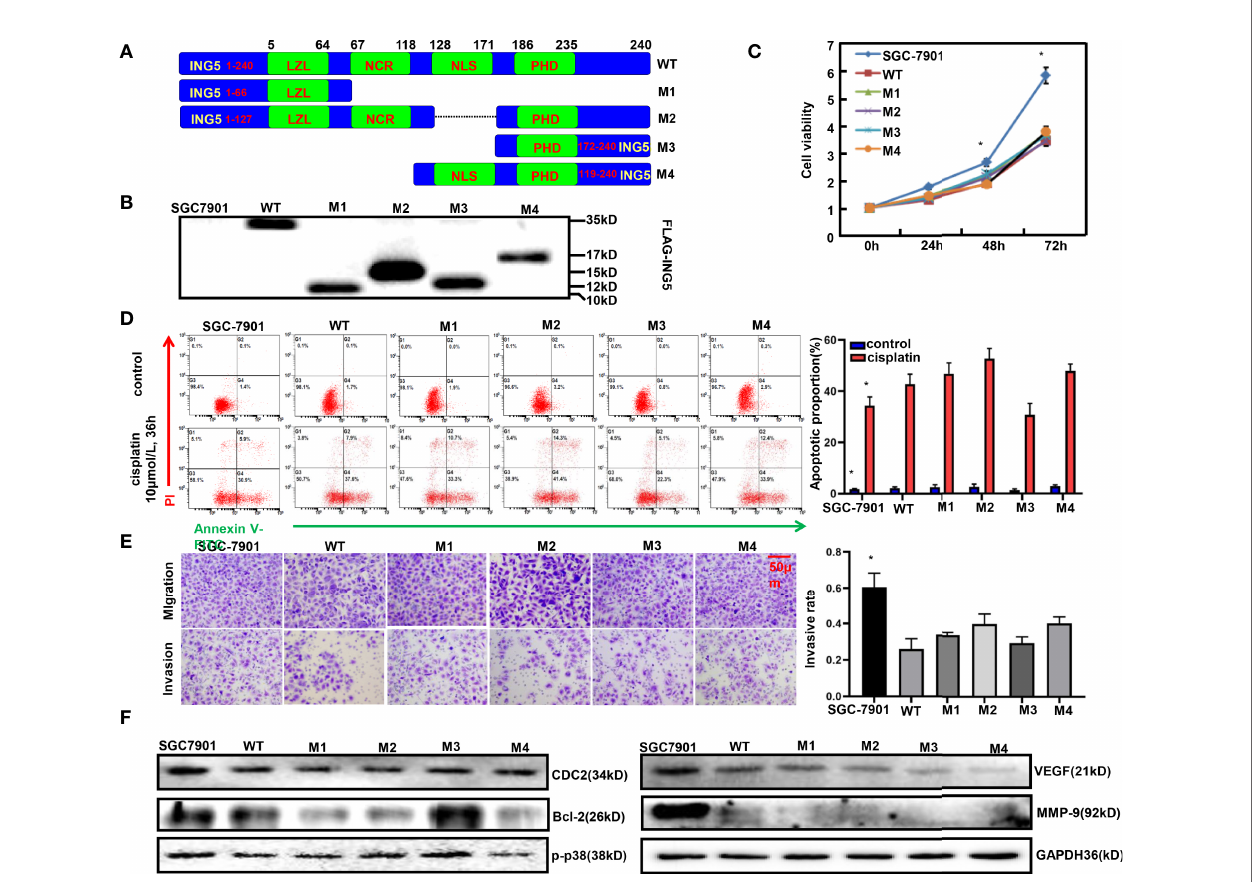
FIGURE 5 | The effects of ING5 domains on phenotypes and related proteins of gastric cancer cells FLAG-tagged wild-type (WT) and mutant (M1 – M4) ING5 fragments were inserted into pcDNA3.1 vector (A) . These WT and mutant ING5-expressing plasmids were transfected into SGC-7901 cells by Western blot (B) , and all transfectants were subjected to the examination of cell viability (C) . After treatment with cisplatin (10 m mol/L, 36 h), we also employed PI-Annexin V-FITC staining to examine apoptosis (D) . Transwell assay was utilized to observe migration and invasion (E) . Finally, phenotype-related proteins were screened by western blot (F) . Note: *, compared with mutant,